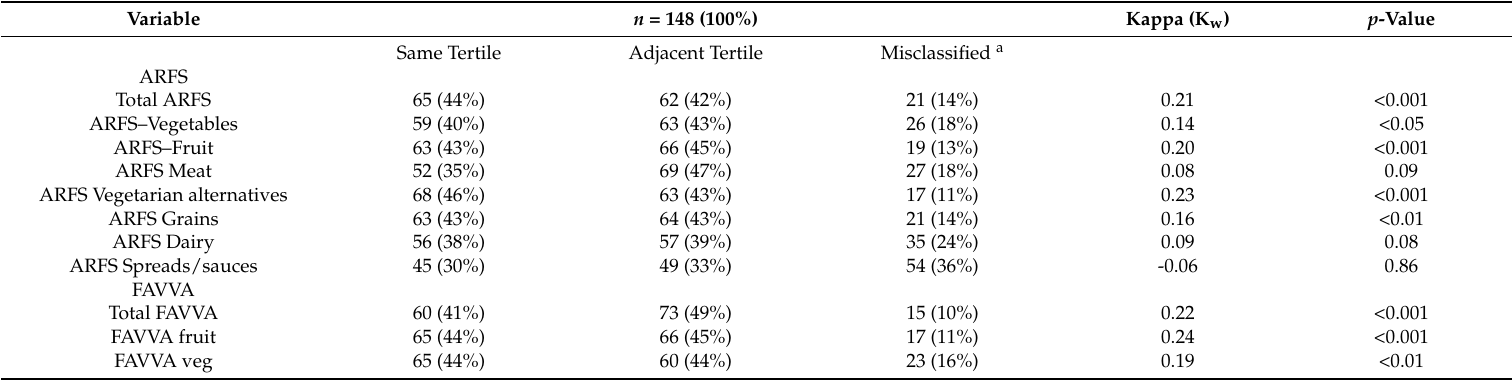
Table 3. Extent of agreement measured using weighted Kappa (K w ) statistics between tertiles of skin yellowness (overall b*) and two dietary indices: (i) The Australian recommended Food Score (ARFS) and (ii) the Fruit and Vegetable VAriety Score